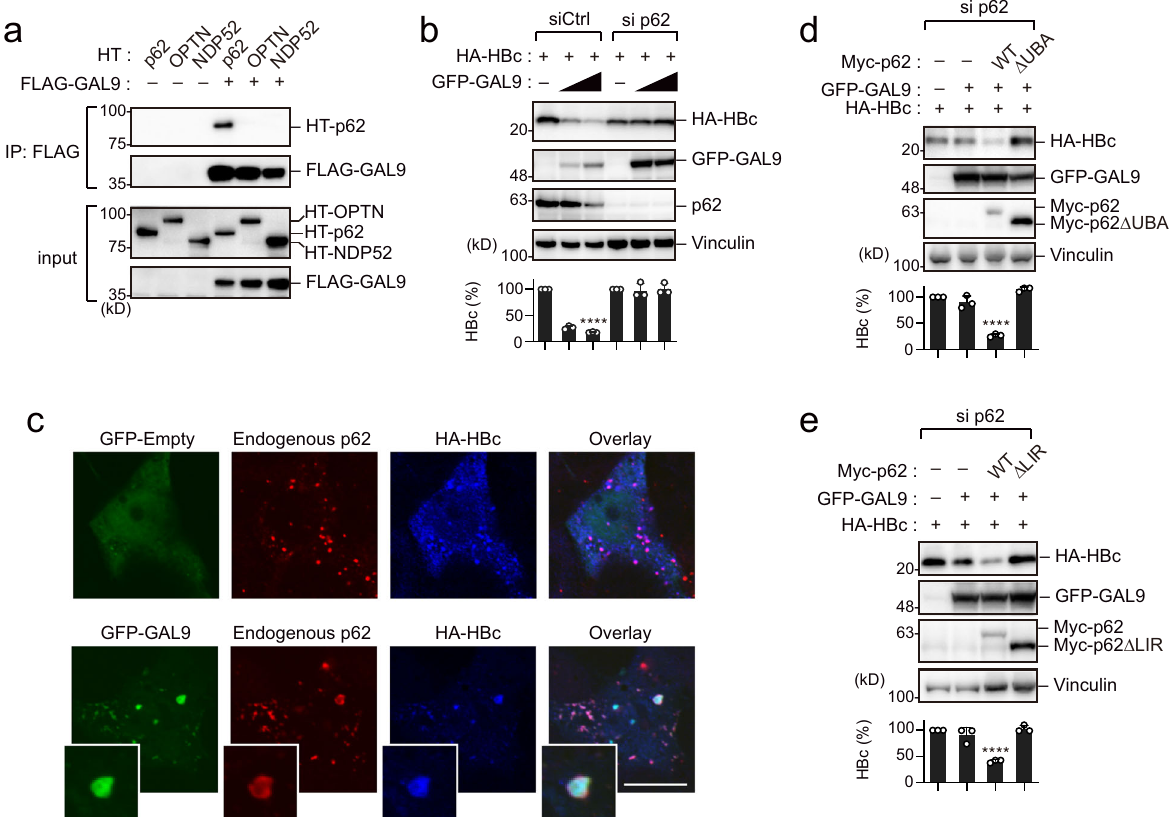
Fig. 4 GAL9 degrades HBc via p62-mediated selective autophagy. a GAL9 interacts with p62. Immunoprecipitation assay was performed on HepG2 cells expressing FLAG-GAL9 and indicated HT-fused proteins. Cell lysates were precipitated with anti-FLAG antibody, followed by immunoblotting. b p62 is required for GAL9 activity. HepG2 cells were transduced with control- (Ctrl) or p62-targeting siRNA, and then transfected with vectors expressing HA-HBc and GFP-GAL9. Cells were subjected to immunoblotting analysis to detect the indicated proteins. c GAL9 promotes colocalization of p62 and HBc. Micrographs show HepG2 cells expressing FLAG-HBc (blue) with or without GFP-GAL9 (green). Endogenous p62 was stained in red. Scale bar, 10 µ m. Another view of the cell image is shown in Supplementary Fig. 5b. d , e The ubiquitin-binding domain (UBA) and LC3-interacting region (LIR) of p62 are required for GAL9-mediated HBc degradation. HepG2 cells were transduced with p62-targeting siRNA, and then transfected with vectors expressing HA- HBc, GFP-GAL9, and siRNA-resistant Myc-p62 (WT, Δ UBA, or Δ LIR). Cells were subjected to immunoblotting analysis to detect the indicated proteins. Bar charts in b , d , e indicate the ratio of HBc over Vinculin, as determined by densitometry, and are presented as a mean ± SD ( n = 3 experiments). **** P < 0.0001, two-tailed unpaired t -test. Immunoblots and micrographs are representative of experiments with similar results ( n ≥ 2). Source data are provided as a Source Data fi